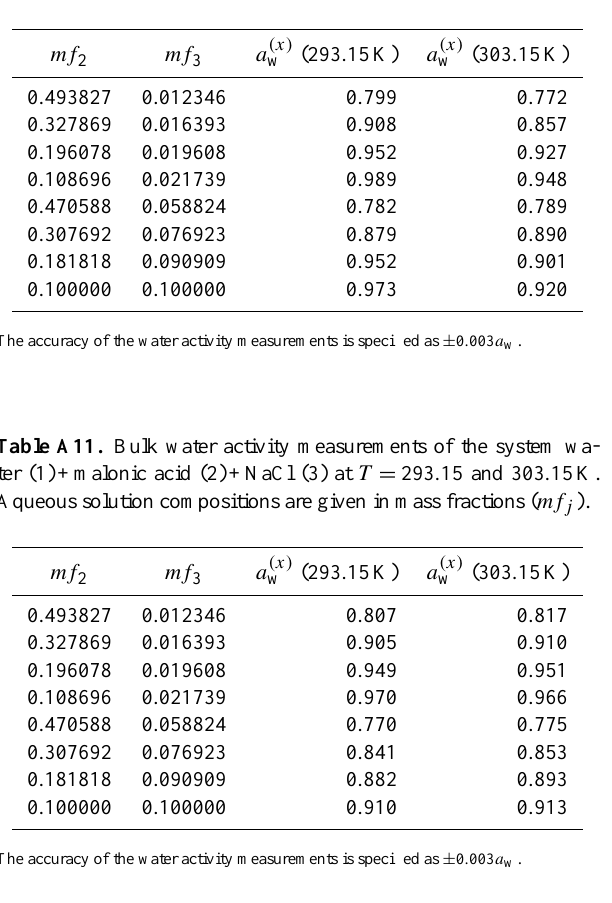
Table A10. Bulk water activity measurements of the system water (1)+malonic acid (2)+Na 2 SO 4 (3) at T = 293 . 15 and 303 . 15K. Aqueous solution compositions are given in mass fractions ( mf j ).